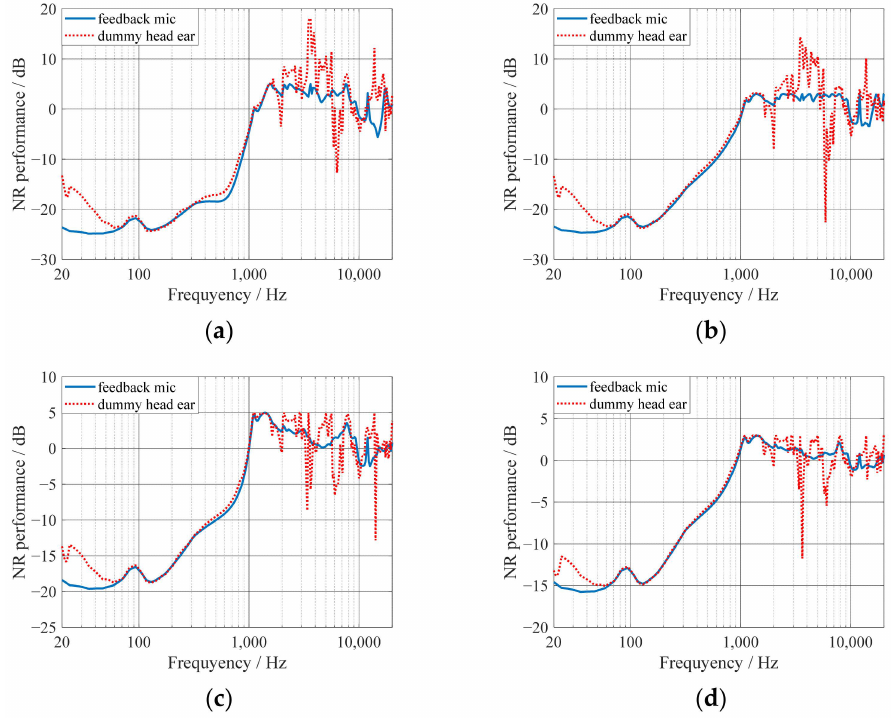
Figure 5. Simulation results of the NR performances: ( a ) δ = 5 dB and ( b ) δ = 3 dB with Method 1, ( c ) δ = 5 dB and ( d ) δ = 3 dB with Method